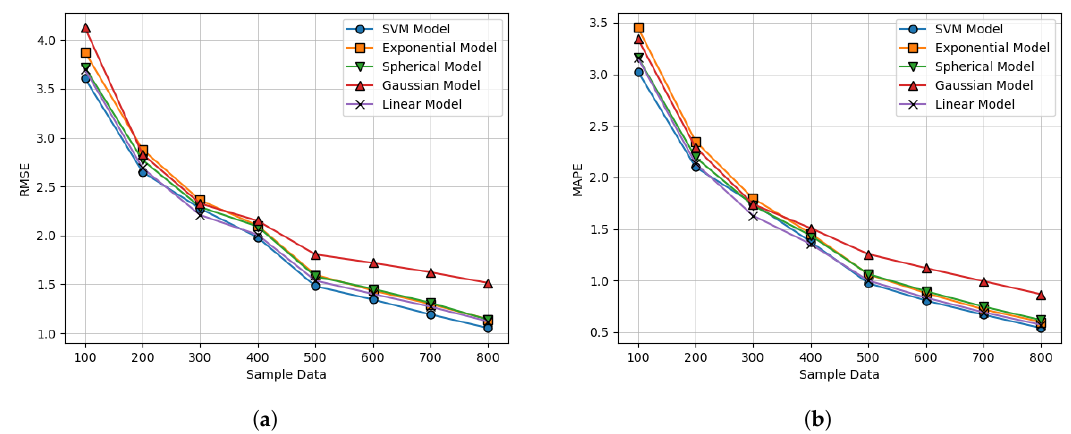
Figure 14. Performance comparison for the distinctive variogram modeling approach according to the number of ESDs in the sense of minimizing ( a ) the RMSE, and ( b ) the